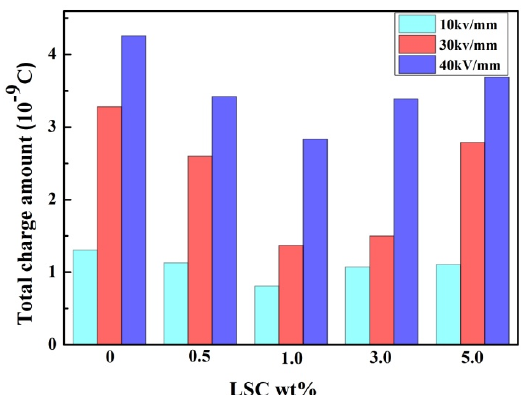
Figure 11. The total amount of charge in the LDPE when the composite with different LSC content acts as a semiconductive layer.